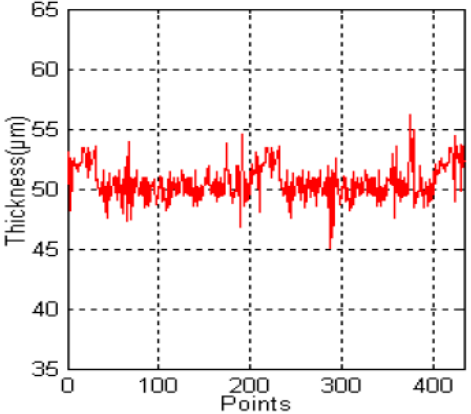
Figure 14. The Paint thickness Curve Spray painting along the U-direction Path. Table 2. The Experimental Results of